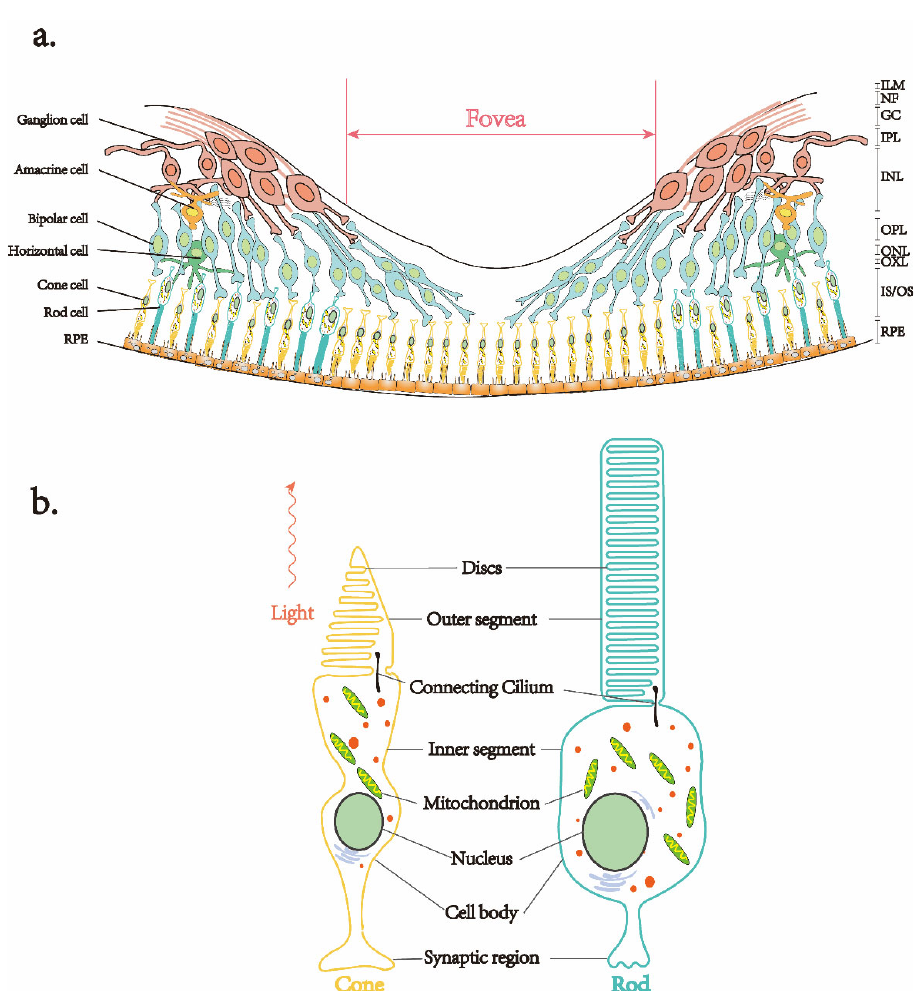
Figure 1. Retinal laminae and photoreceptor cell structure. ( a ) The retina consists of ten layers, of which photoreceptor cells (rod and cone) and retinal pigment epithelium (RPE) are the main target cells for the treatment of RP and other inherited retinal dystrophies. ( b ) The final morphological structure of photoreceptor cell development includes an inner segment, outer segment, and a synaptic terminal. Connecting Cilium transports components, such as proteins, from the inner segment to the outer segment to the sensory discs stacked in the outer segment in order to mediate the onset of light signal transduction.